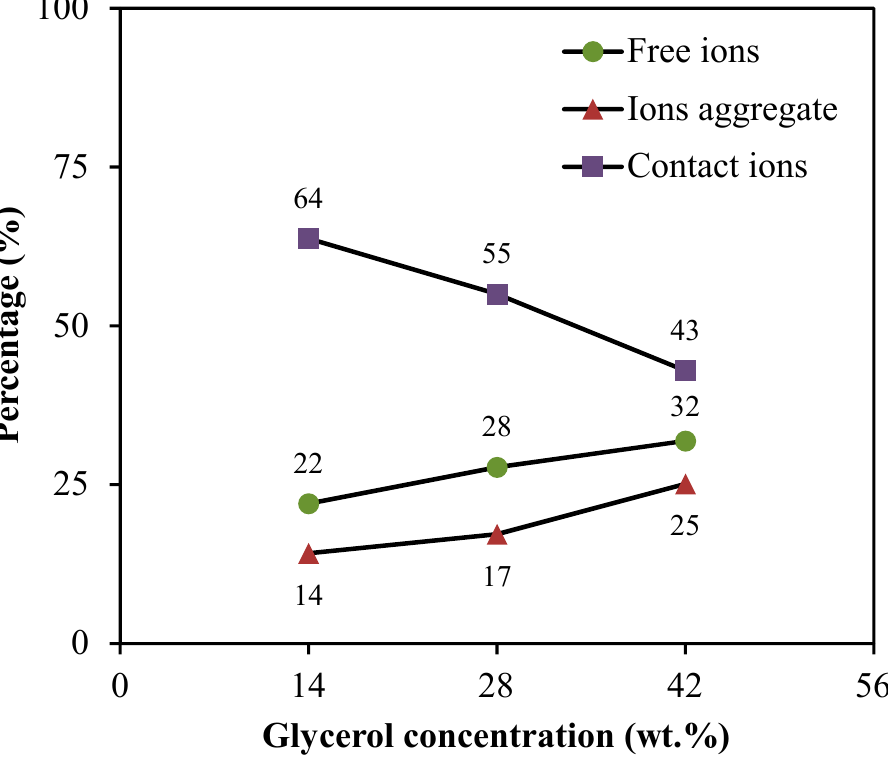
Figure 4. Percentage of free ions, contact ions pairs, and ion aggregates for the electrolytes. Based on the free ions percentage, the transport parameters; number density ( n ), ionic mobility ( µ ), and diffusion coefficient ( D ) can be calculated using Equations (3)–(5), as listed in Table 4. The results illustrate the influence of glycerol concentration on the values of the number density of ions, as well as the ionic mobility and diffusion coefficient. It is noteworthy that the number of ions ( n ) tends to increase steadily as the concentration of glycerol increases. In the meantime, the ionic mobility ( µ ) and diffusion coefficient ( D ) are observed to obey the ionic conductivity trend. Here, it is worth mentioning that the ionic conductivity of the current system is increased by increasing ( n ) value, as revealed by the value of the free ion, which improved progressively by further adding glycerol into the system. The increment of the ionic mobility ( µ ) and diffusion coefficient ( D ) is due to the chain flexibility enhancement caused by the inclusion of glycerol. This is owing to the fact that the incorporation of extra glycerol dissociates extra salts to the free ions, thereby, raising the number of charge carriers in the system. The CSMCD3 electrolyte has the highest values of n , µ and D that optimized at 1.27 × 10 23 cm − 3 , 1.13 × 10 − 8 cm 2 · V − 1 · s − 1 and 2.95 × 10 − 10 cm 2 · s − 1 , respectively. The findings obtained from the ionic transport study in this work can conclude that the ionic conductivity result can be affected by the number density values, hence describes the influence of transport parameters on the ionic conductivity results